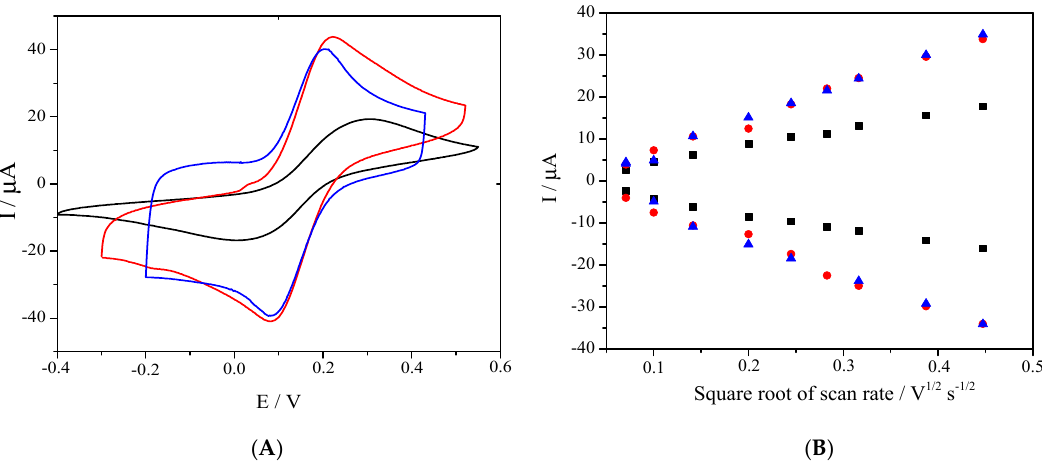
Figure 2. Voltammetric characterization of SPE (black), SPE/MWCNT (red), and SPE/O-MWCNT (blue): ( A ) comparison of cyclic voltammetries for the three electrodes at 100 mV s − 1 ; and ( B ) anodic and cathodic current peaks for the three electrodes at different scan rates: 5, 10, 20, 40, 60, 80, 100, and 200 mV s − 1 . Probe solution: Potassium hexacyanoferrate (II) 1 mmol·L − 1 in KCl 0.1 mol·L − 1